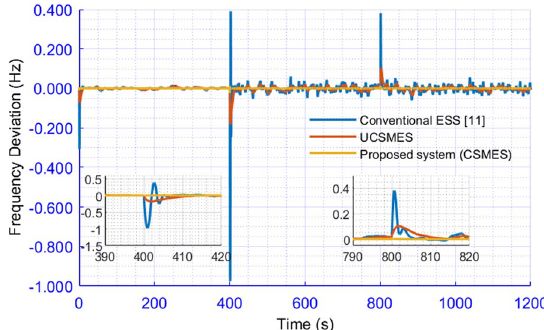
Fig. 10 Frequency deviation of the considered system for scenario A at 30% system